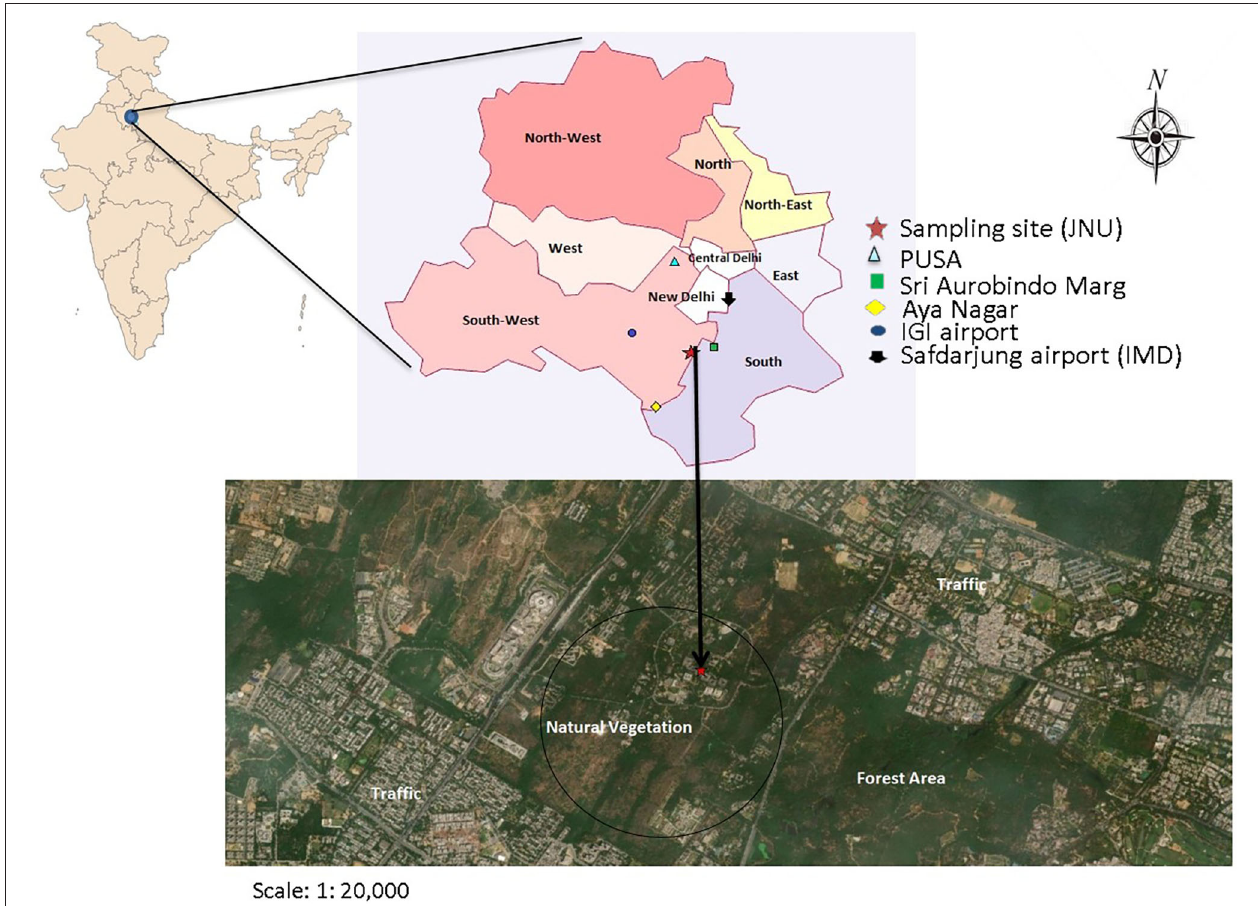
FIGURE 1 | Map of sampling site. All PM 2.5 measurement sites (JNU, PUSA, Sri Aurobindo Marg, Aya Nagar, IGI airport) and Meteorological measurement site (Safdarjung airport) are shown by legends on Delhi map. Google map of region (marked by vegetation and traffic locations) near the sampling site (JNU) is shown in the lower